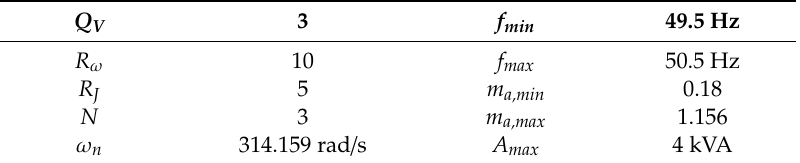
Table 2. MPC controller parameters.